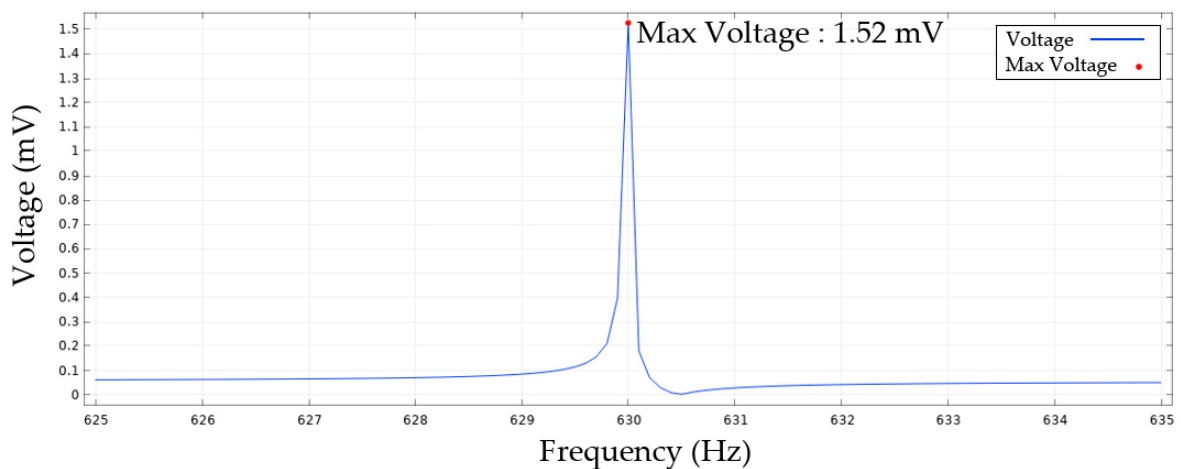
Figure 15. Output voltage from piezoelectric beam II at second mode shape.